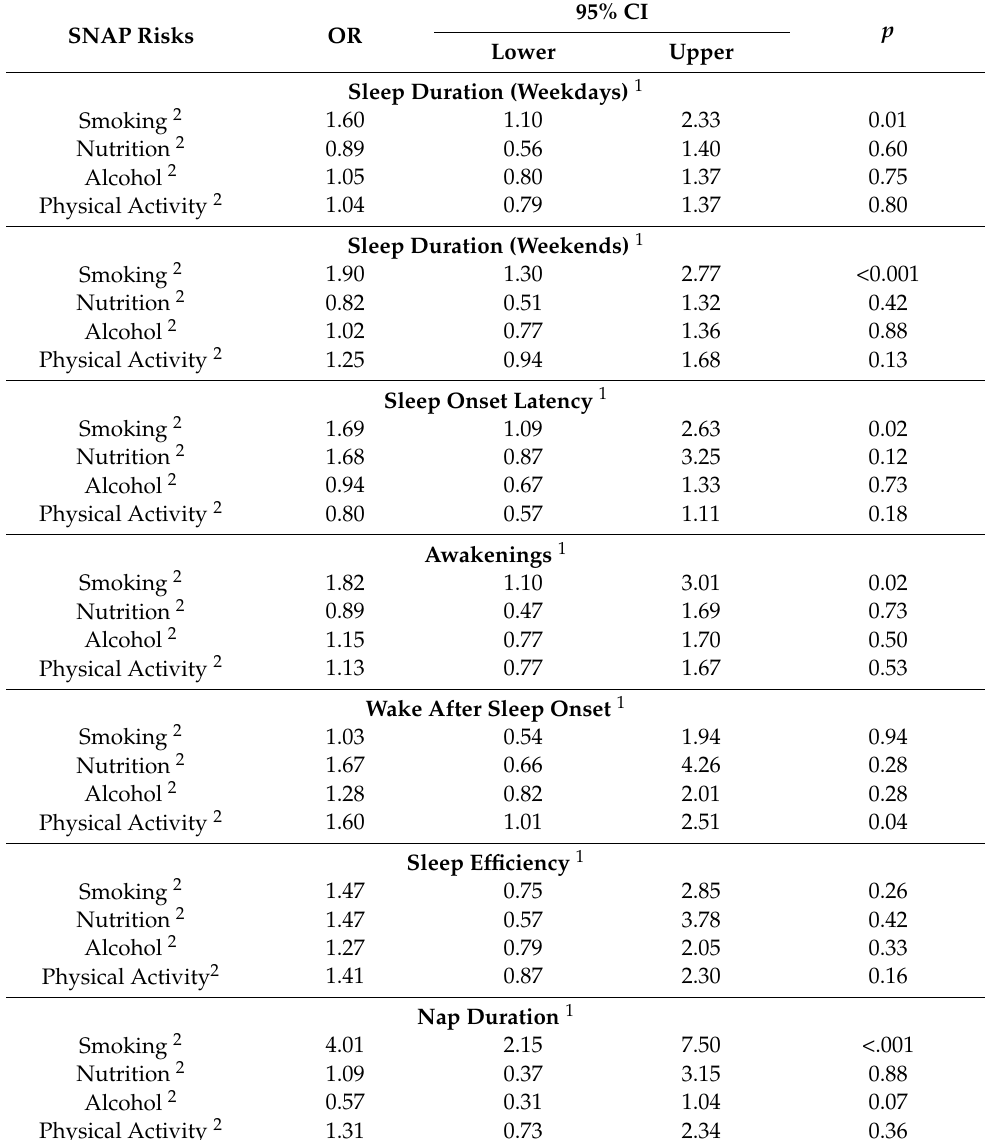
Table 5. Multivariable Associations between SNAP risks and Suboptimal